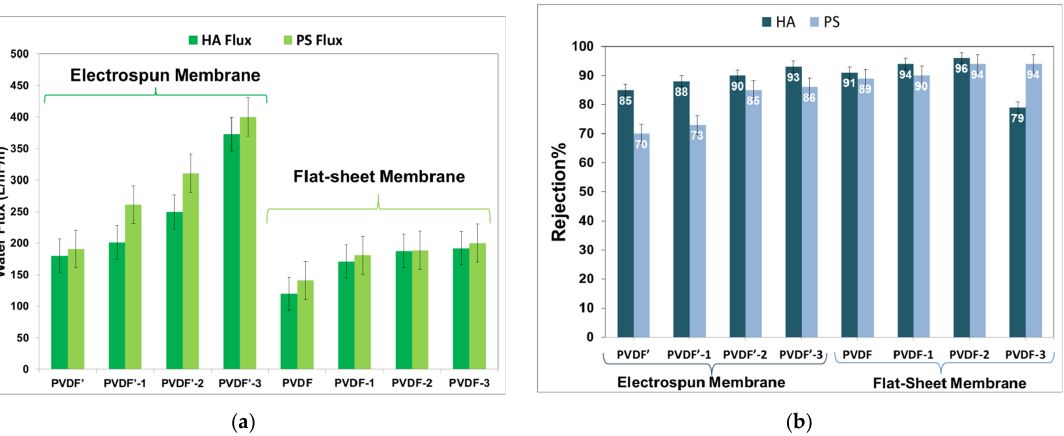
Figure 6. ( a ) The HA and PS Flux of electrospun fibrous and flat-sheet PVDF membranes corresponding to each membrane sample. ( b ) The HA and PS rejection efficiency of the electrospun fibrous and flat-sheet PVDF membranes corresponding to each membrane sample.